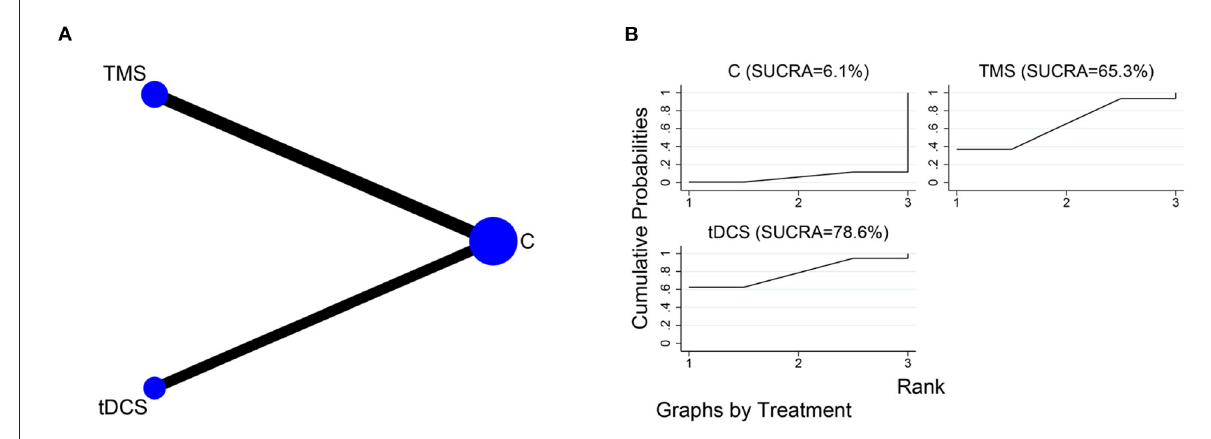
FIGURE8 NMA of MBI and FIM scores at different NIBS. (A) Network plot; (B) SUCRA